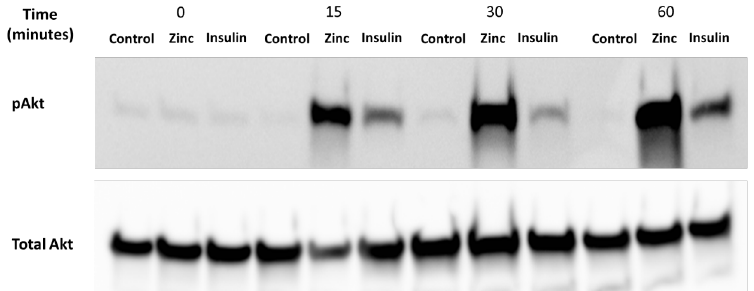
Figure 2. Analysis of pAkt in C2C12 mouse skeletal muscle cells treated with control (DMSO), zinc, NaPy, and insulin over 60 min. Time is shown from 0, 15, 30, and 60 min and total Akt was used as an internal loading control. The levels of pAkt were normalised to total Akt.